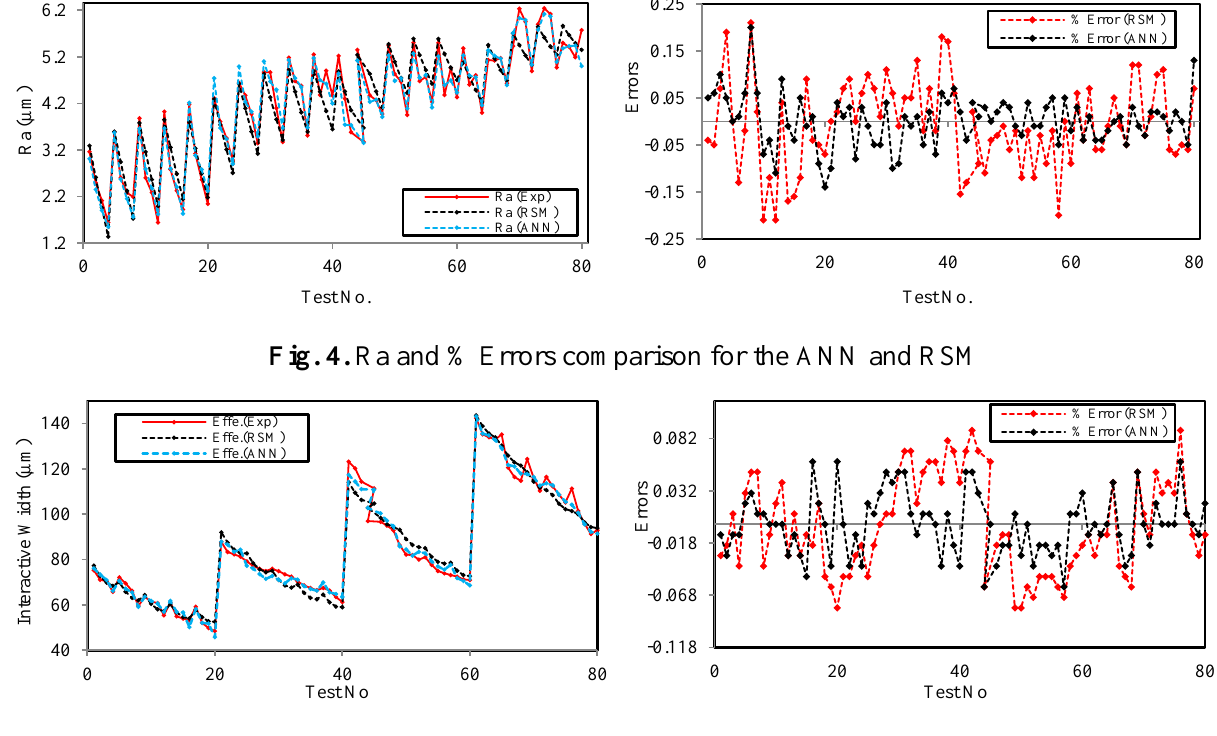
Fig. 5. I.W.Z and % Errors comparison for the ANN and RSM